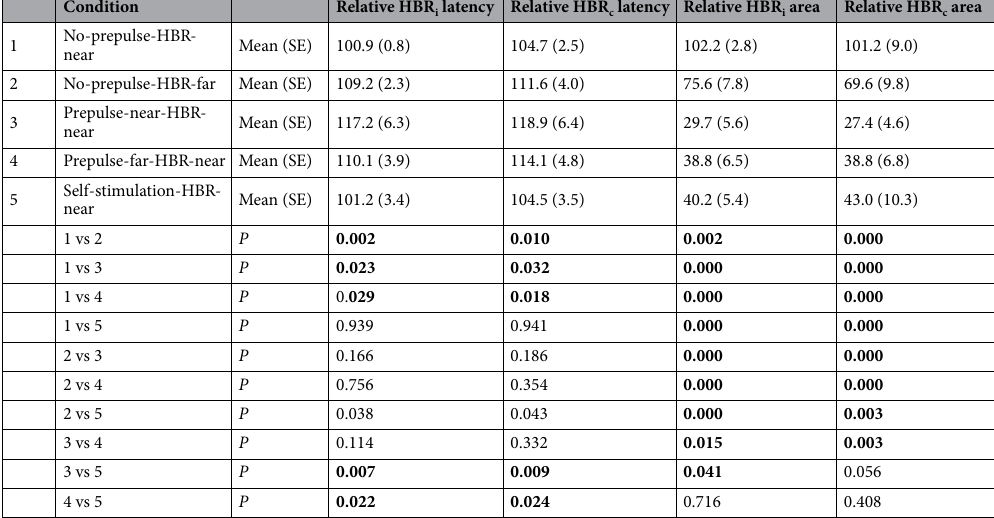
Table 2. Hand-blink reflex (HBR) parameters. Figures are mean values (standard error, SE) for group average data in percentage of individual median values of the orbicularis oculi muscle ipsilateral to the stimulated dominant median nerve in condition 1 ( no-prepulse-HBR-near ). P values (paired t-tests) indicating statistically significant differences following Benjamini–Hochberg procedure to compensate for multiple testing are in bold. HBR i ipsilateral, HBR c